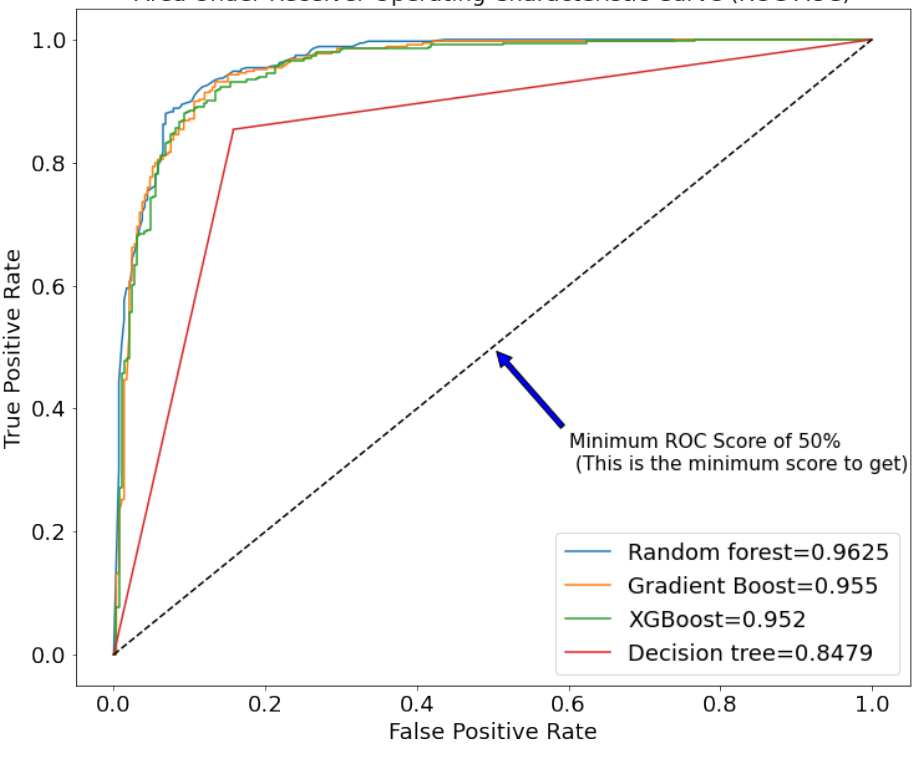
Figure 3. ROC AUC of different tree-based machine learning models before